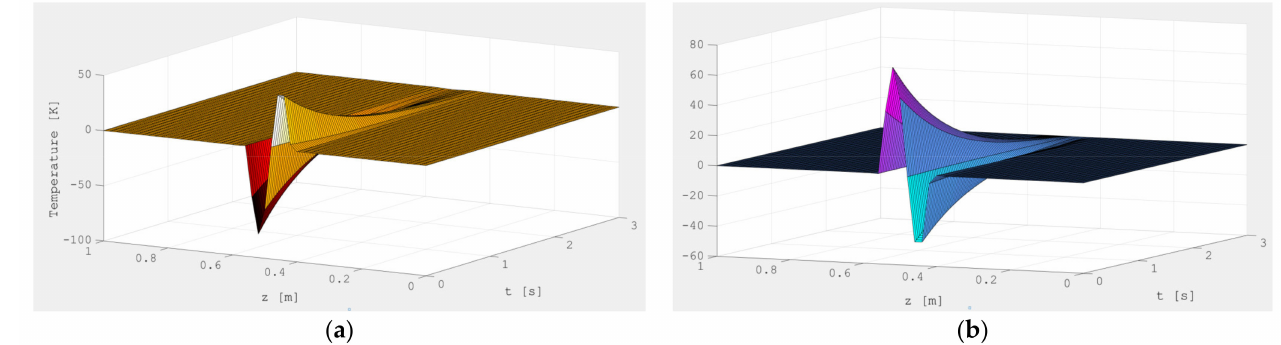
Figure 4. Surface graphs: ( a ) deviation of the silica temperature ∆Θ ( t , z ); ( b ) optimal control ∆ u opt ( t , z ) at τ = 3 [s].